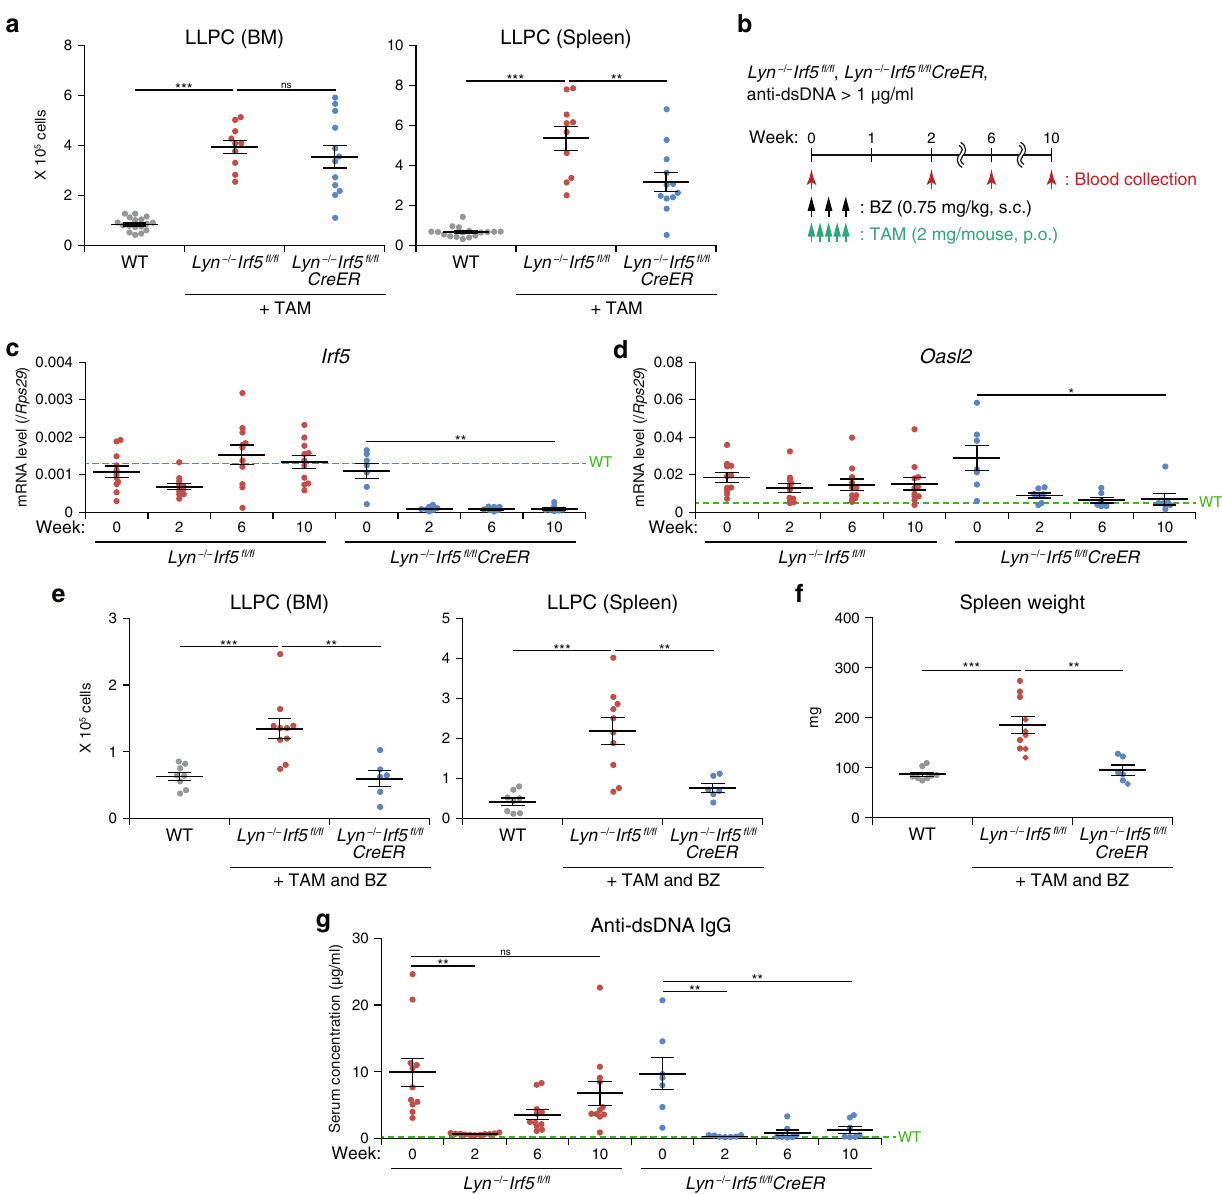
Fig. 4 Maintenance of remission by the Irf5 cKO in the Lyn-de fi cient mouse model of SLE. a The LLPC number in bone marrow (BM; left) or in the spleen (right) from WT ( n = 17), Lyn − / − Irf5 fl / fl ( n = 10), and Lyn − / − Irf5 fl / fl CreER ( n = 12) mice at 24 – 28 weeks after TAM treatment as in Fig. 3a (40 – 46 weeks of age) was analyzed by fl ow cytometry. b The scheme of the Irf5 cKO combined with BZ-induced LLPC depletion; s.c. subcutaneously. c , d Irf5 and ISG expression. Irf5 ( c ) and Oasl2 ( d ) mRNA levels in peripheral blood from Lyn − / − Irf5 fl / fl ( n = 11) and Lyn − / − Irf5 fl / fl CreER ( n = 7) female and male mice (29 – 32 weeks of age at week 0) treated as in b were analyzed by RT-qPCR. e The LLPC number in BM (left) and spleen (right) from WT ( n = 8), Lyn − / − Irf5 fl / fl ( n = 10), and Lyn − / − Irf5 fl / fl CreER ( n = 6) mice at 12 weeks after the fi rst injection (41 – 44 weeks of age) as in b was analyzed by fl ow cytometry. f Spleen weight of mice in e . The circles and diamonds denote the female and male mice, respectively. g Autoantibody production. Serum anti- dsDNA IgG from mice in c was quanti fi ed by ELISA. Data were pooled from two independent experiments. Horizontal bars ( a , c – g ) indicate mean ± SEM. Dashed lines ( c , d , g ) denote mean data from WT mice ( n = 5). * P < 0.05, ** P < 0.01, *** P < 0.001 (two-sided Student ’ s t test in a , e , f ; two-sided paired t test in c , d , g